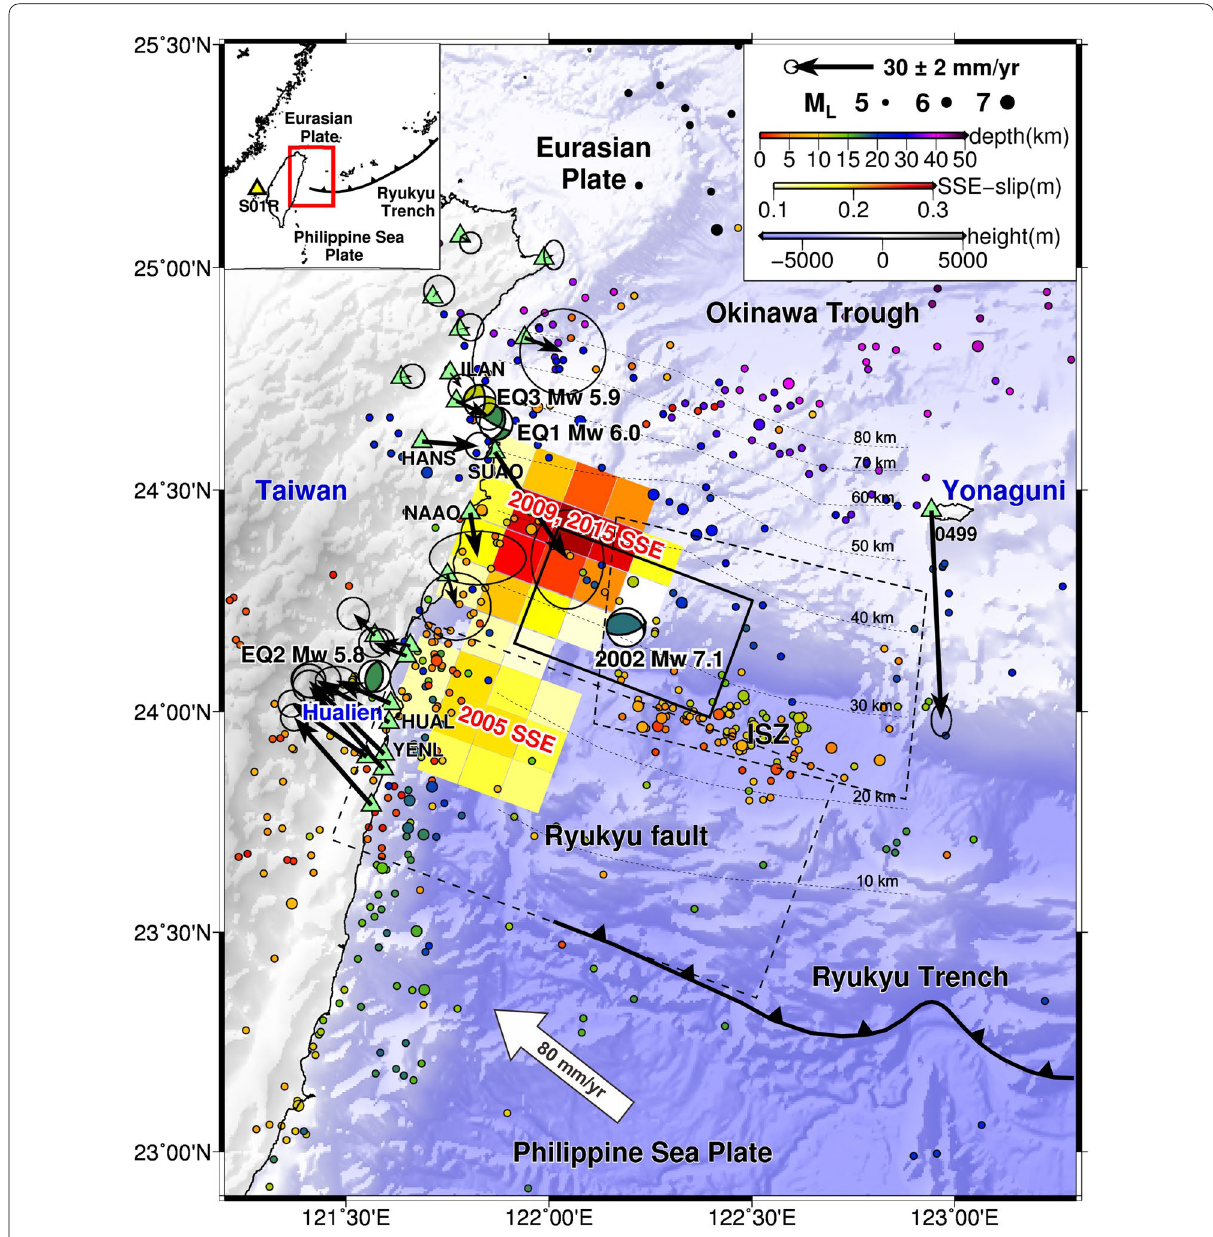
Fig. 1 Overview of SSEs and earthquakes in the southernmost Ryukyu subduction zone from 1991 to 2018. The black rectangle represents the previously studied fault plane of the 2002 March 31 M w 7.1 Hualien offshore earthquake (Lee et al. 2009). The dotted contours show isodepths of the subducting plate interface from Wu et al. (2009). The cumulative slip of SSEs derived from Chen et al. (2018) and the seismicity derived from the relocated earthquake catalog (Wu et al. 2008) are colored. The dotted rectangles represent the seismogenic structures on the plate interface. ISZ: interplate seismogenic zone (Kao 1998). The horizontal displacements (black arrows) represent the interseismic velocity on the onshore GNSS stations (green triangles) from 2007 to 2016. The horizontal displacements have corrected the effects from the 2002 M w 7.1 earthquake, three local earthquakes (EQ1 to EQ3 with focal mechanisms), and SSEs. EQ1 to EQ3: the 2002 May 15 M w 6.0, the 2004 May 1 M w 5.8, and the 2005 March 7 M w 5.9 doublet earthquakes. The yellow triangle denotes the reference S01R